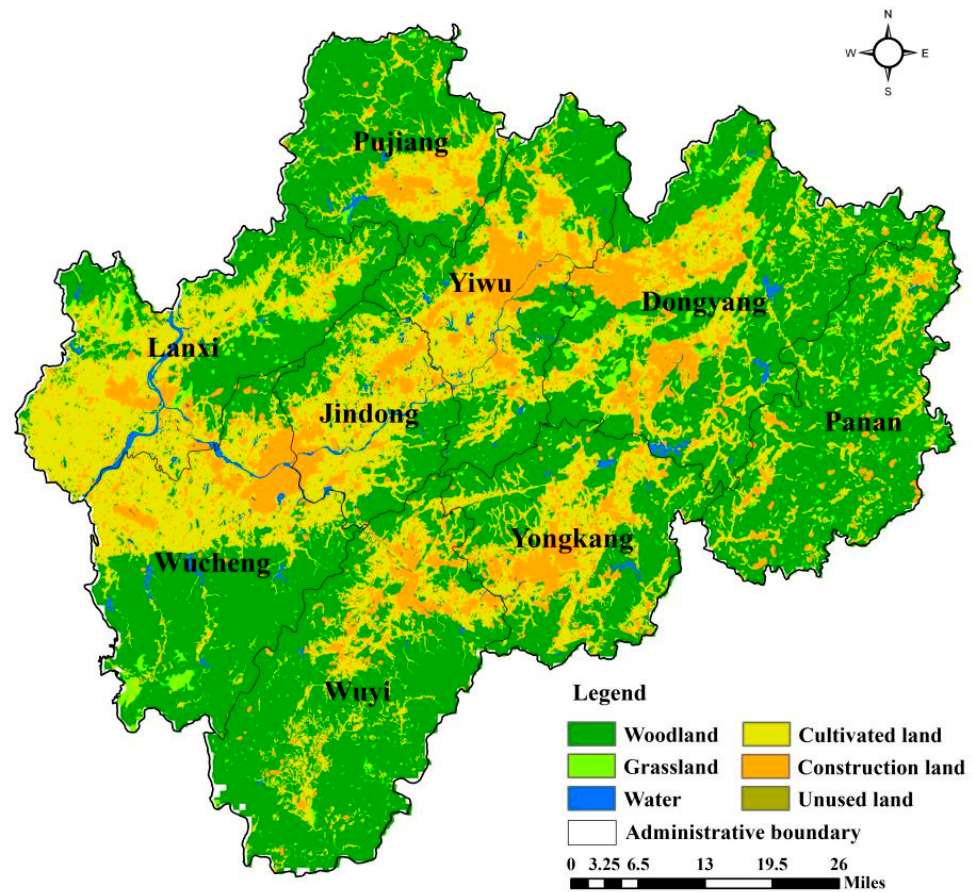
Figure 5. Image of predicted land-use in 2030. Based on the forecasted results for the land-use pattern in 2030, carbon emissions were predicted. The carbon sources are expected to increase by 29.6% by 2030. Carbon sinks are predicted to reduce by 7.8%, and total carbon emissions are predicted to increase by 30% compared to 2018. Compared with the 2005-2018 period, the growth rate of carbon emissions is predicted to drop significantly but still remain at a relatively high level. With the gradual decrease in the average carbon emissions intensity of